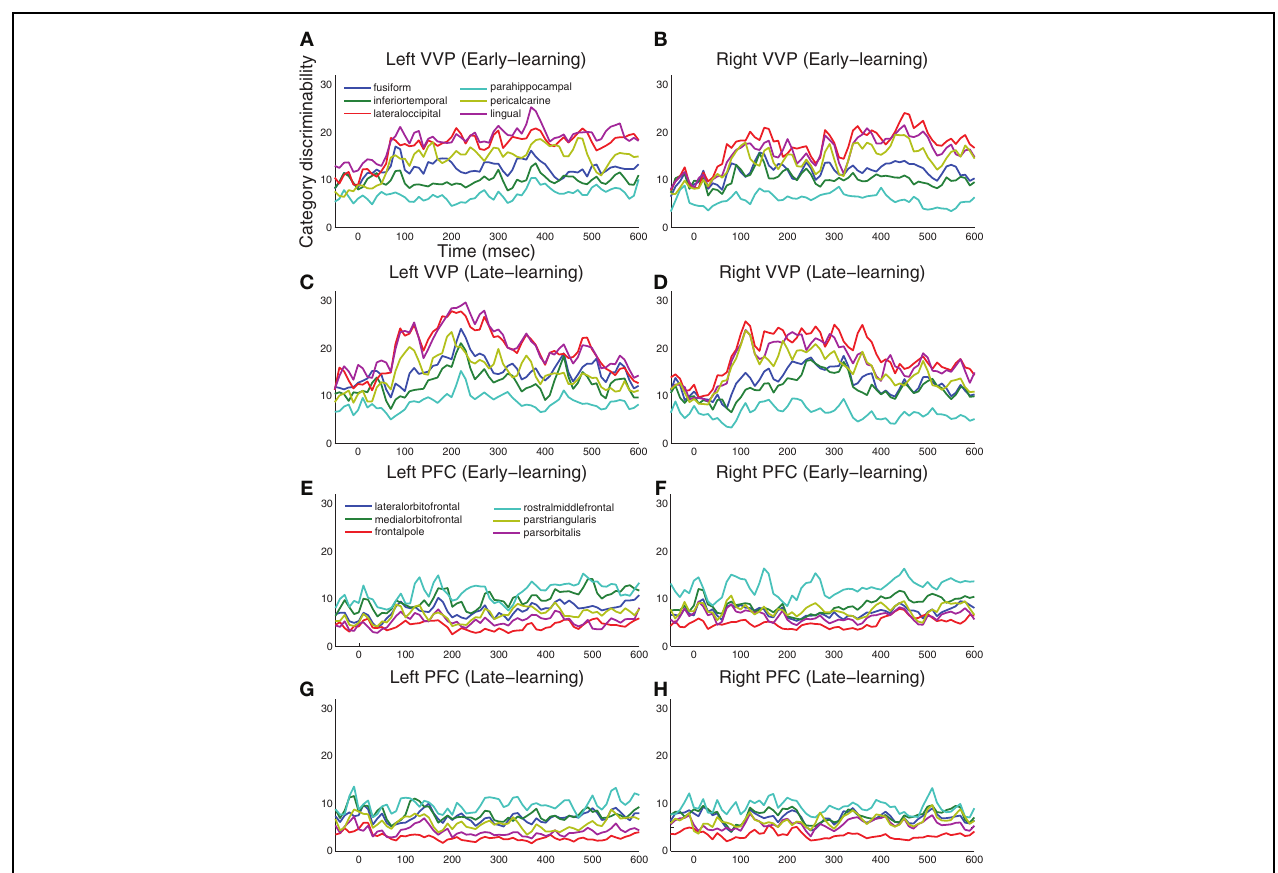
FIGURE 4 | Category-discriminative time courses in ventral visual and prefrontal cortices. (A) Group-level discriminative time courses in right-hemispheric VVP contrasting dipole responses in trials containing A and B blob categories during early learning. (B) Discriminative time